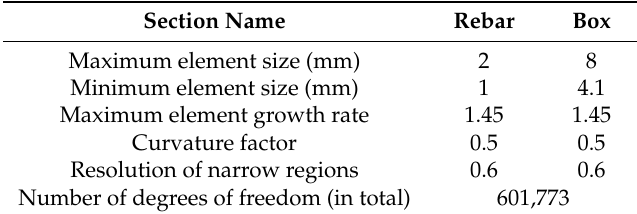
Figure 3. Box used in analysis; arrows show the resultant vector for X, Y, and Z components of Earth’s magnetic field. Table 3. Mesh specifications of rebar and box in the initial simulation.